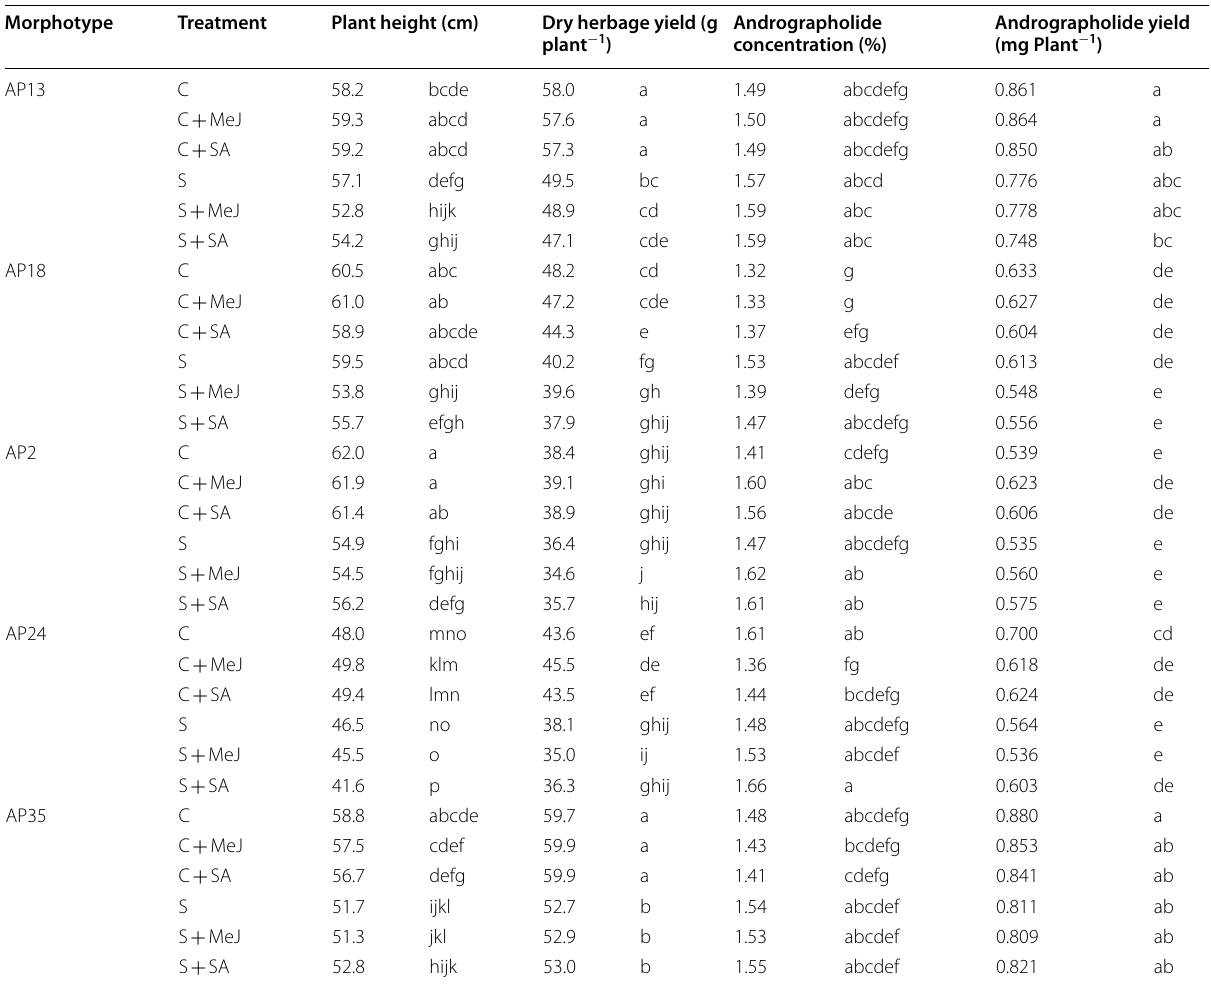
Table 4 Plant height, dry herbage yield, andrographolide concentration and andrographolide yield in leaves of Andrographis paniculata at 140